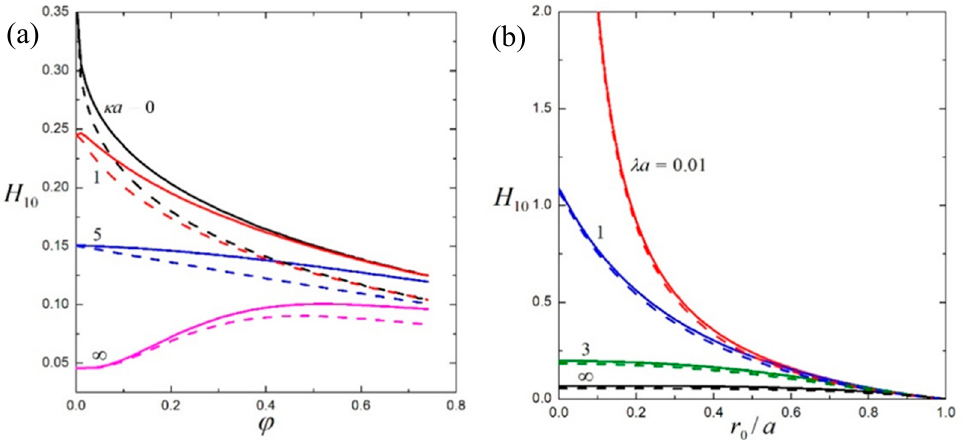
Figure 5. The electrophoretic mobility coefficient 01 H =ϕ and 0.1 . The solid and dashed curves represent the calculations for the Happel and Kuwabara models, respectively.